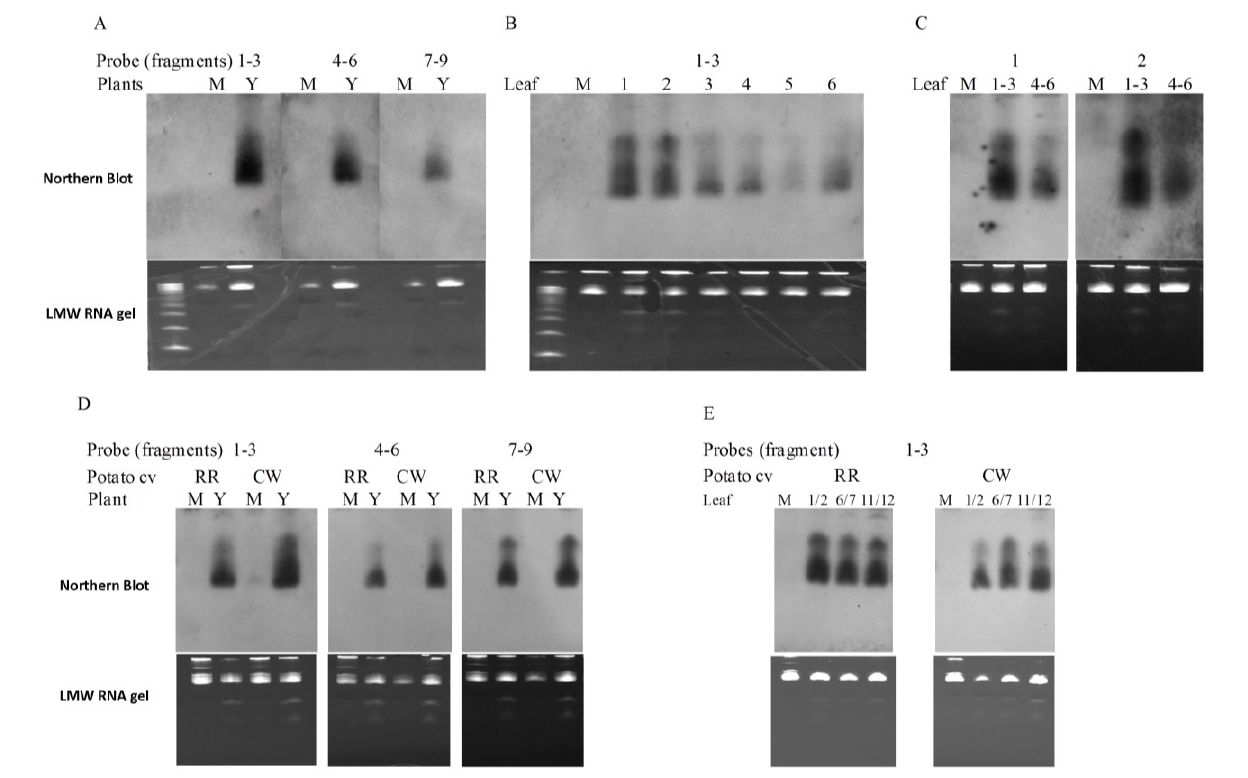
Figure 7. Northern blot detection of PVY-derived small RNA (siRNA) in leaves of tobacco and potato plants infected with PVY N:O -Mb58. ( A ) Detection of PVY-siRNA in leaves (12 dpe) of PVY (Y)- and mock (M)-inoculated tobacco plants using fragments covering various segments of the complete PVY genome; ( B ) Detection of PVY-siRNA in leaves of PVY-inoculated potato plants using probes of PVY fragments 1–3; ( C ) Detection of PVY-siRNA in different leaves of PVY-inoculated tobacco plants using probes of PVY fragment 1; ( D ) Detection of PVY-siRNA in leaves (30 dpe) of PVY- and mock-inoculated potato plants using fragments covering various segments of the complete PVY genome; ( E ) Detection of PVY-siRNA in various leaves of PVY-inoculated potato plants using probes of PVY fragments 1–3. The PVY fragments 1–9 cover the nucleotide segment of PVY N:O genome 5'end–1200, 1100–2400, 2300–3500, 3400–4600, 4500–5700, 5600–6800, 6700–7900, 7800–9000, 8900–3'end, respectively. The far left lane in low-molecular-weight (LMW) gels is 10 bp DNA step ladder (Promega. Bottom to top: 10 bp to 100 bp in exactly 10 bp increments). M, mock; Y, PVY; RR, potato cv. “Ranger Russet”; CW, potato cv. “Cal